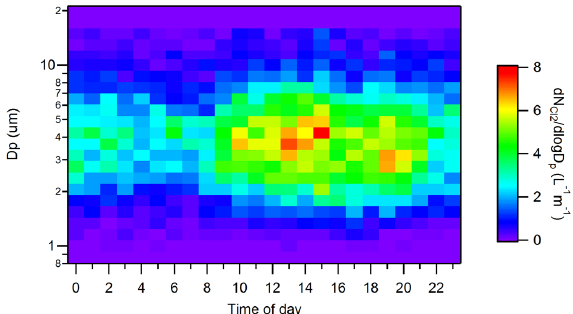
Fig. 8. Diurnal average size distribution of WIBS cluster 2 product of the period shown in Fig.